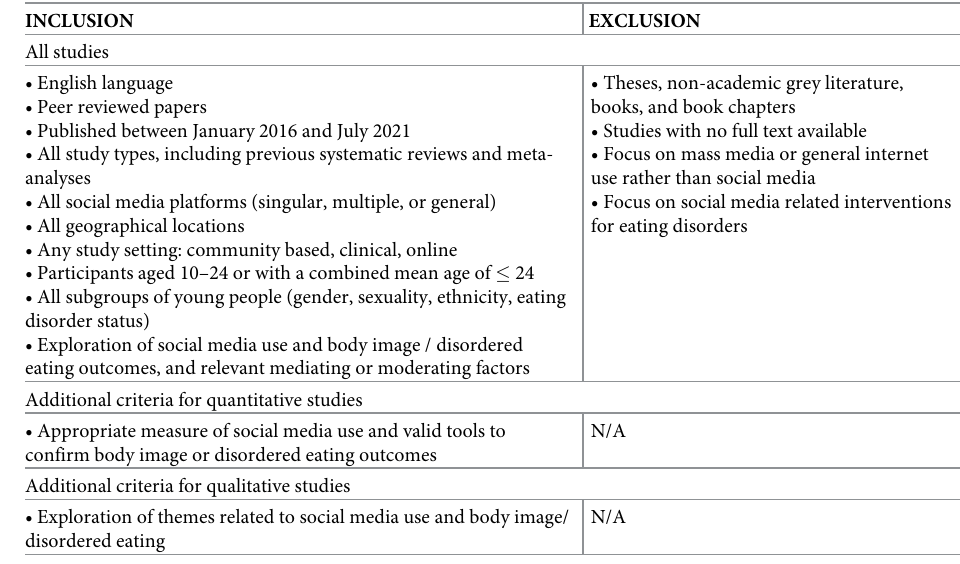
Table 5. Inclusion and exclusion